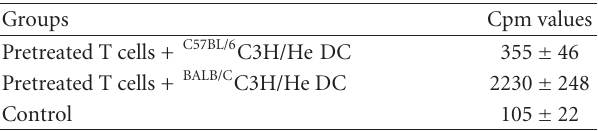
Table 2: MLR of pretreated T cells and recipient DCs pulsed with di ff erent donor